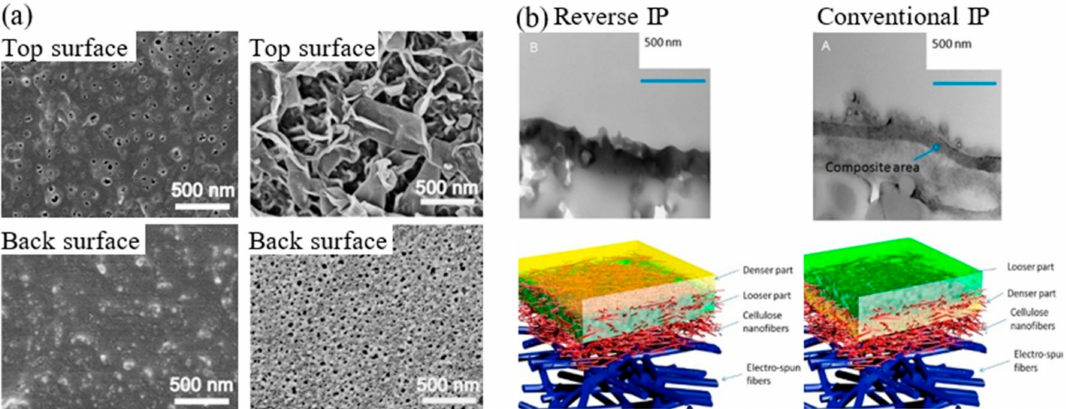
Figure 12. ( a ) SEM images of top and back surface of PA film formed via reverse IP and conventional IP [133] and ( b ) TEM (top) and schematic image (bottom) of reverse IP and conventional IP. The dense and loose parts of the PA layer are represented by yellow and green color, respectively